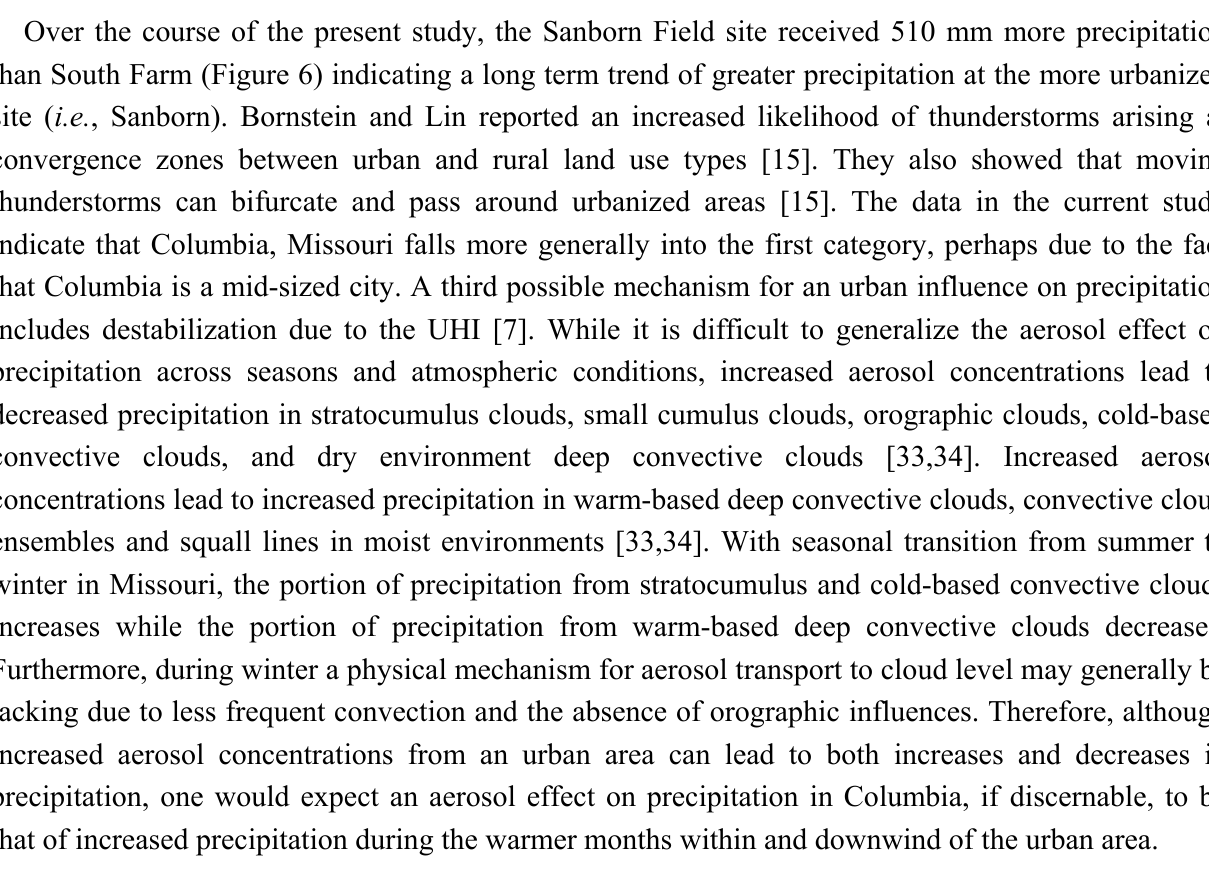
Figure 6. Annual precipitation trends at Sanborn and South Farm long-term climate monitoring sites from 18 January 1995 to 8 October 2013, Columbia, Missouri,